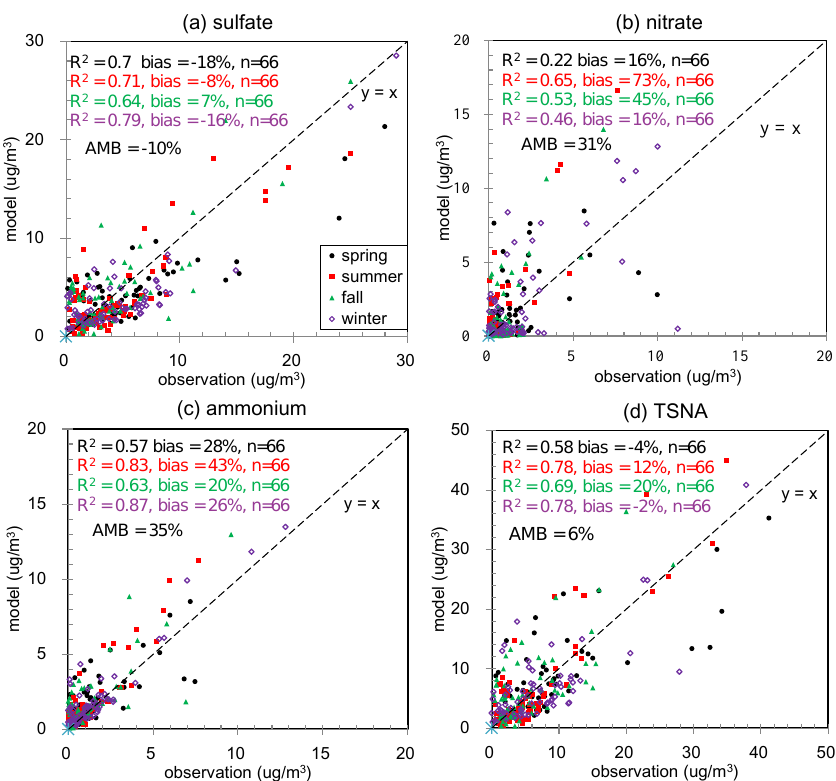
Fig. 5. Scatter plots of simulated versus observed SNA concentrations at 22 (the 4 EANET sites inside China have no observation data for SNA) sites in East Asia, including 2 sites in China (BB and MY) and 20 sites from other countries. Values are seasonal mean for 2006. The black dots represent spring, the red squares represent summer, the green triangles represent fall, and the violet hollow diamonds represent winter. AMB = annual mean bias. The square of correlation coefficient ( R 2 ) , normalized mean bias, and annual mean bias (AMB) are given in each scatter plot. The y = x relationship (dashed lines) is